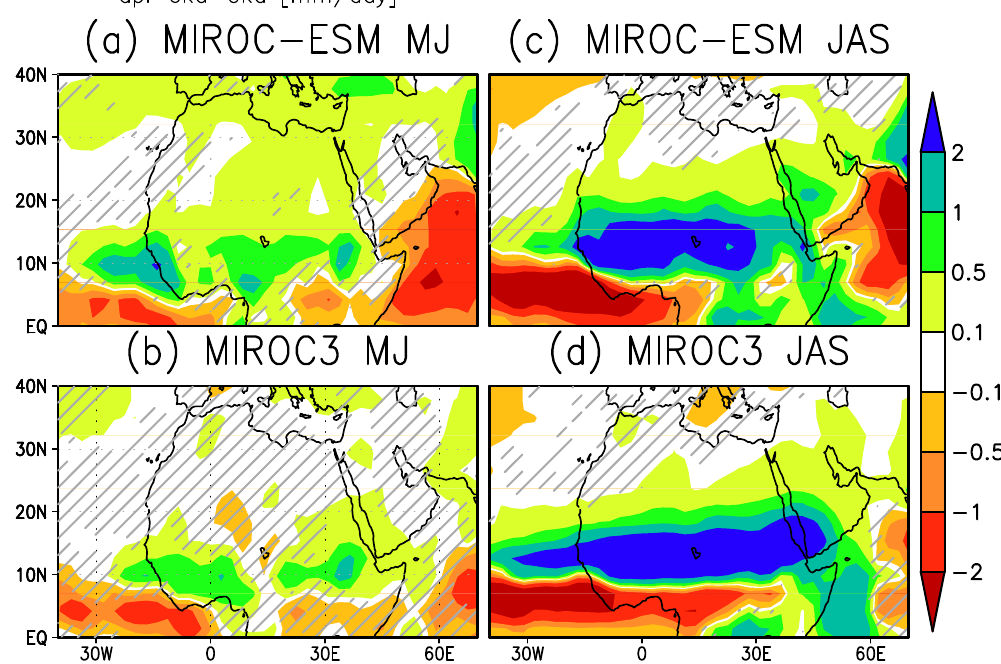
Fig. 14. 6–0ka precipitation change (colored shading) (mmday − 1 ) in MJ (left panels) and JAS (right panels) obtained with MIROC-ESM (upper panels) and MIROC3 (lower panels). The hatched areas denote regions where the precipitation amounts in 0 and 6ka do not differ significantly in a t test